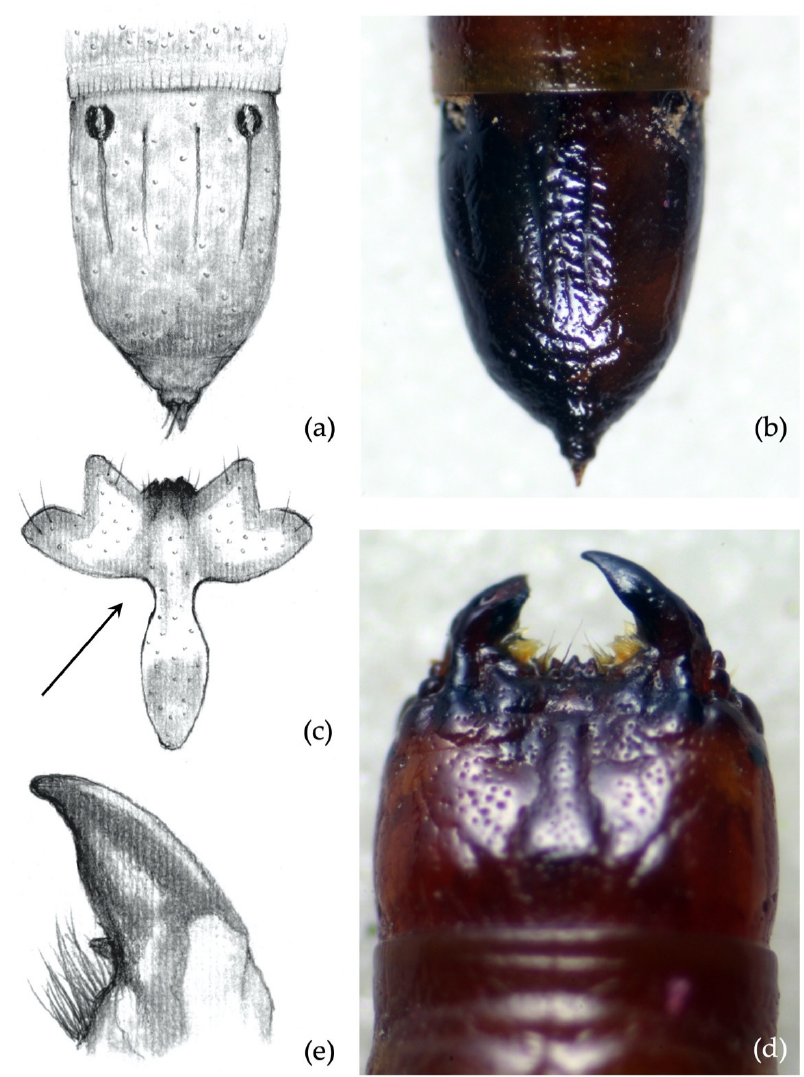
Insects 2021 , 12 , x 20 of 23